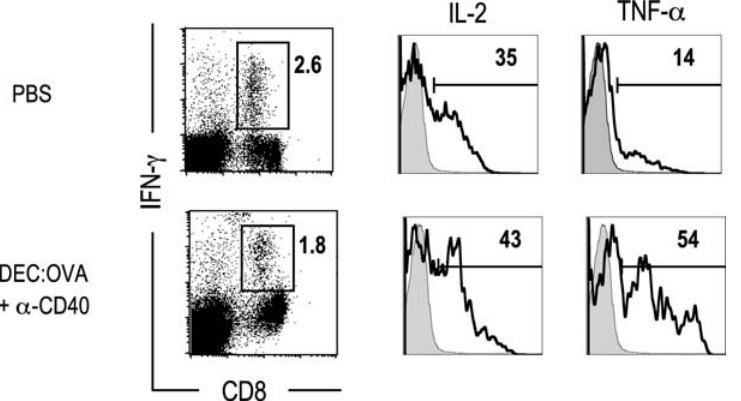
Figure 4. Memory CD8 + T cells primed with anti-CD40 produce multiple cytokines. Mice were primed with PBS or anti-DEC:OVA + anti- CD40, and boosted with anti-DEC:OVA + anti-CD40 at day 60. At the peak of the secondary response (at d 7 after boosting in PBS-primed mice; at d 4 in anti-DEC:OVA + anti-CD40-primed mice), splenocytes were stimulated with OVA(257-264) peptide and the production of IFN- c , IL-2 and TNF- a were examined by intracellular staining. Representative of two